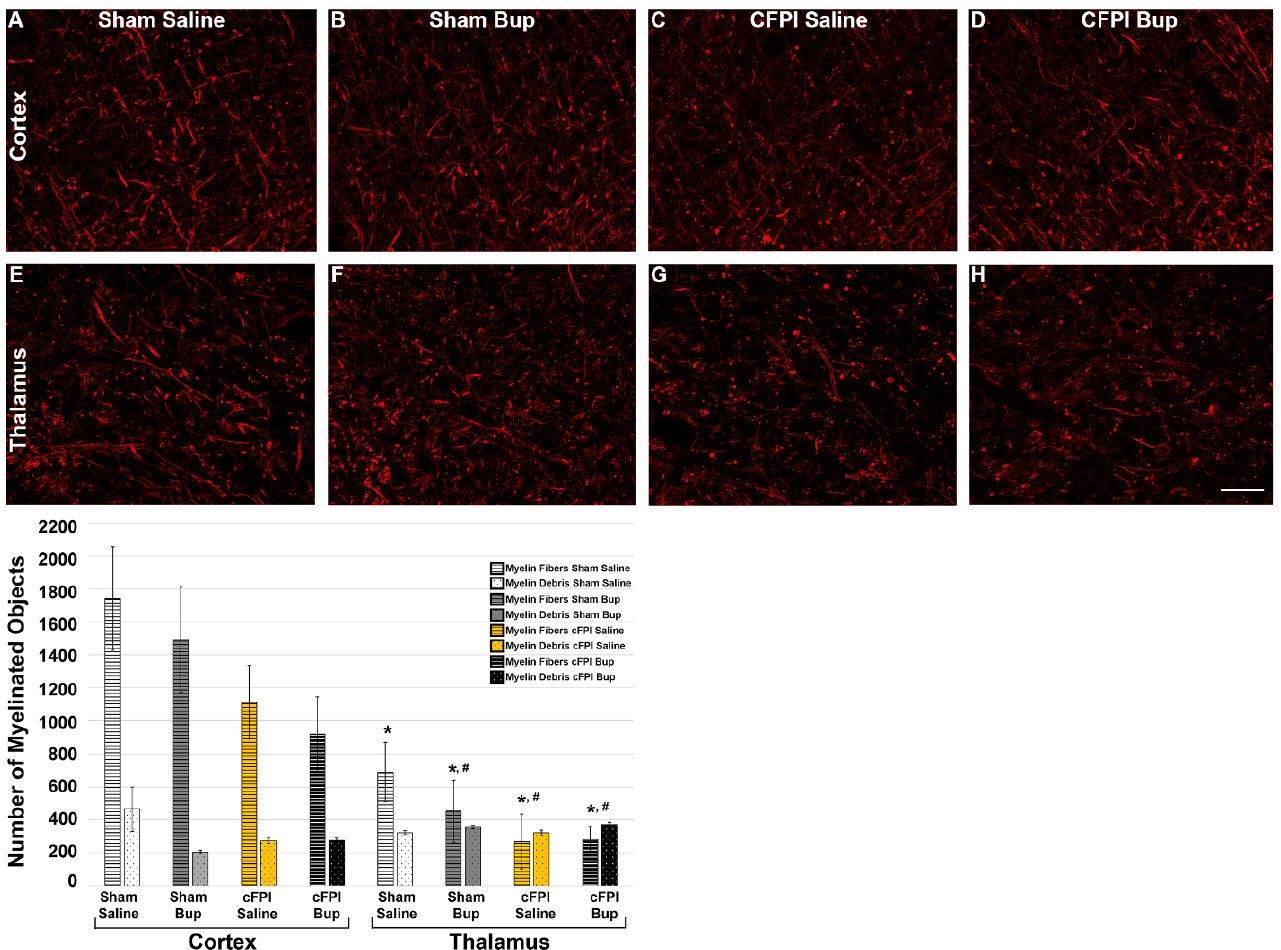
Figure 6. The number of myelin fibers is not significantly altered with cFPI or Bup-SR-Lab (Bup) treatment 4w post-injury. Representative photomicrographs of myelin basic protein (MBP) labeling in the ( A – D ) cortex and ( E – H ) thalamus of ( A , B , E , F ) sham or ( C , D , G , H ) cFPI animals treated with ( A , C , E , G ) saline or ( B , D , F , H ) Bup. Bar graph depicting the average number of MBP+ fibers (bars with horizontal lines) and MBP debris (bars with dots) in saline and Bup treated animals 4w after sham or cFPI. The number of myelinated debris was consistent among groups. There were fewer myelin fibers in the thalamus compared to the cortex, however, there was no Bup, or injury effect observed. n = 6 rats/group. Scale = 50 µ m. * p < 0.05 compared to Cortex-Sham-Saline; injury differences: # p < 0.05 compared to Cortex-Sham-Bup. n = 6 rats/group. Mean ± SEM. * p < 0.05 compared to sham saline cortex, # p < 0.05 compared to sham Bup